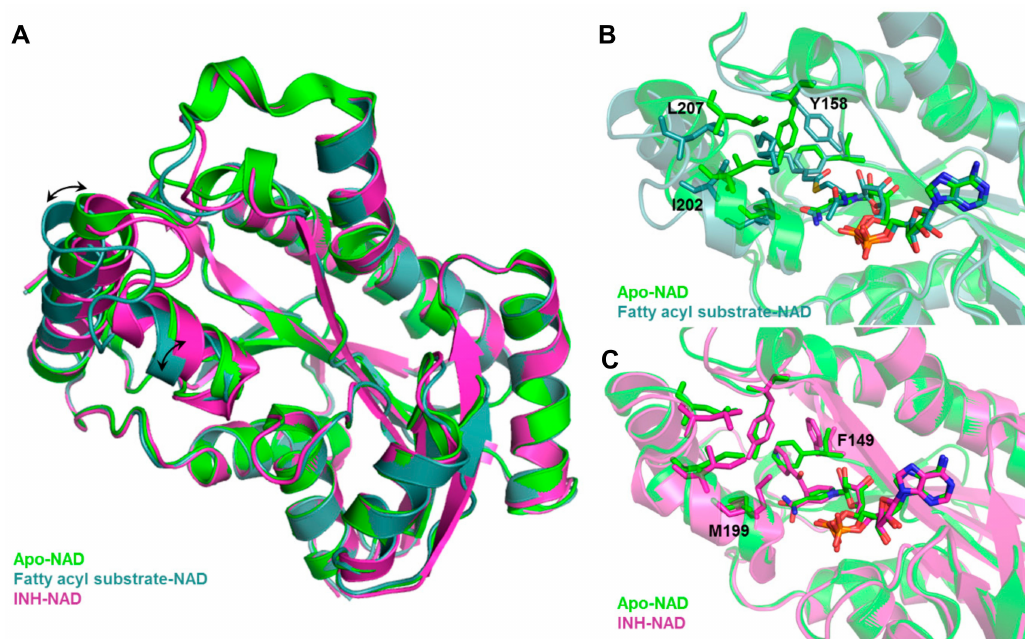
Figure 3. Backbone and sidechain flexibility shown by Mtb InhA, apo vs. fatty acyl-bound vs. INH-bound. ( A ) Structural overlay of apo, fatty acyl-bound, INH-bound Mtb InhA shows backbone movement upon substrate (fatty acyl) binding. Binding site comparison of ( B ) fatty acyl-bound and ( C ) INH-bound vs. apo Mtb InhA structure shows distinct changes in residue side chain positions and conformations. Black arrows indicate movement of alpha helices, side chains that showed large conformational change upon fatty acyl or INH binding are labelled in